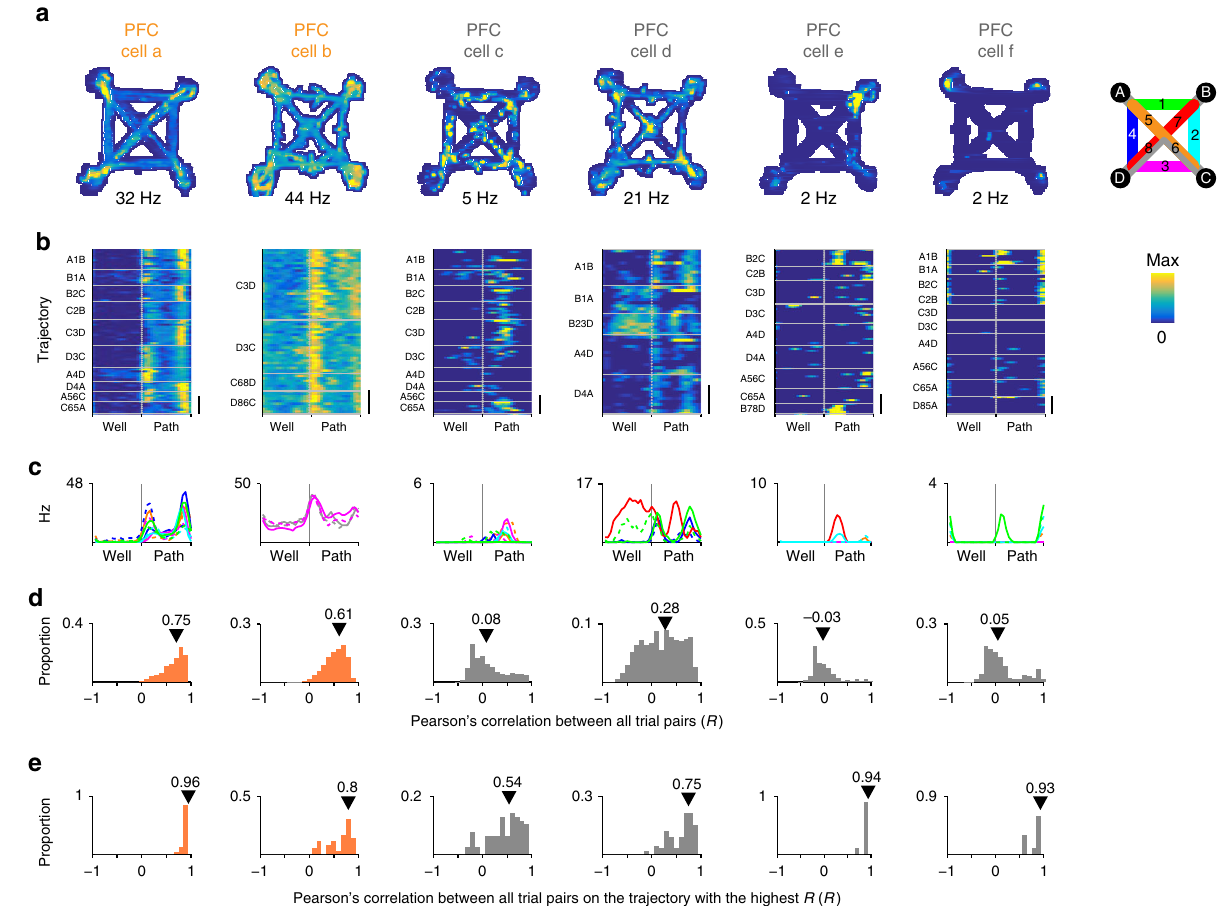
Pearson’s correlation between all trial pairs on the trajectory with the highest R ( R ) Fig. 4 Task fi ring patterns for example SWR reactivated and not reactivated path-preferring PFC cells. a Occupancy normalized spatial fi ring maps for path- preferring PFC cells. Maximum fi ring rate of each cell is indicated below each panel. Cells a and b show signi fi cant SWR reactivation. Cells c – f are not reactivated. Cells a and c were recorded simultaneously. b Time normalized trial fi ring rate map for the cells in a . The vertical dotted line separates well and path trial phases. Horizontal solid lines separate trials on each trajectory. Each trajectory is labeled to indicate the start and the end well locations (letters), and paths taken (number) according to the maze schematic in a . Maximum fi ring rate and color scale are the same as in a . Scale bar = 10 trials. c Median fi ring rate for each trajectory. Line color key is indicated by maze schematic in a – d . Distribution of pairwise Pearson ’ s correlation for trial fi ring pro fi le across all trials. All-trial similarity ( R median ) is the median of the distribution and is indicated by the arrowhead. e Distribution of pairwise Pearson ’ s correlation of trials on the trajectory with the highest median pairwise correlation. Maximum within-trajectory similarity ( R max ) is the median of the distribution and is indicated by the